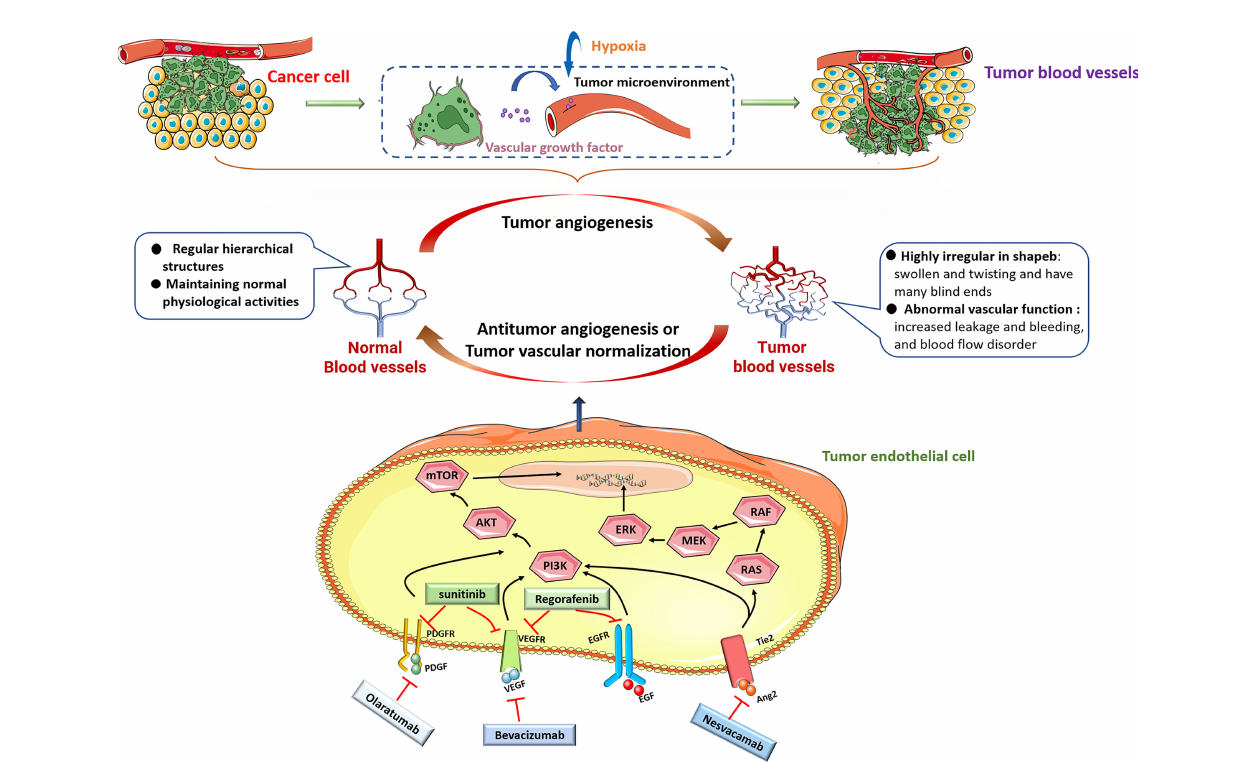
FIGURE 1 | Under pathological conditions including hypoxia, most tumor cells upregulate the expression of many angiogenic factors, including VEGF, PDGF, EGF and Ang, and secrete them into the tumor microenvironment. When these molecules bind to their cognate receptors, then stimulate downstream signaling, including PI3K/AKT and RAS/MEK/ERK signaling pathways to promote tumor growth and angiogenesis. Monoclonal antibodies beracizumab, olaratumab, nesvacamab and small molecule drugs sunitinib and regorafenib can block the interaction between pro-angiogenic factors and their receptors, and inhibit tumor